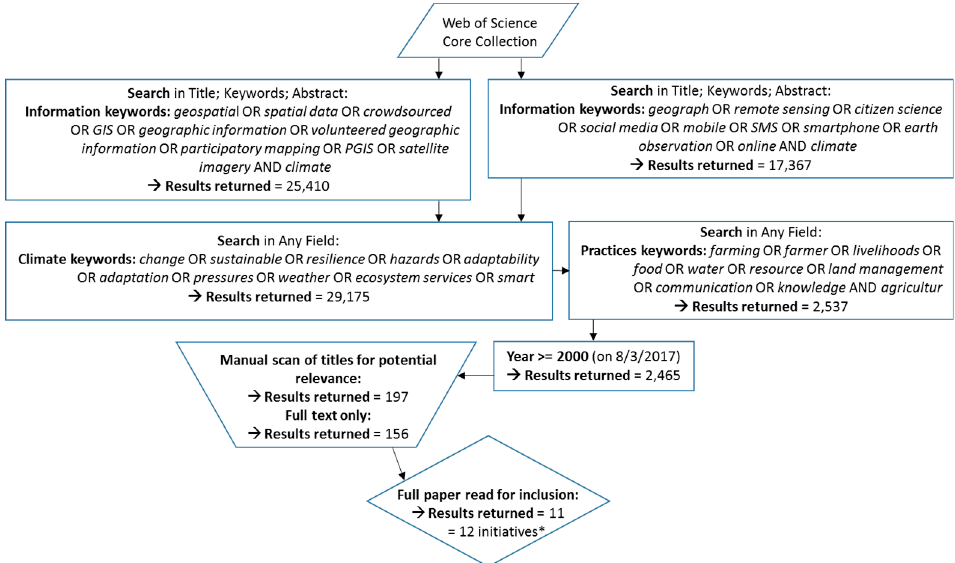
Figure 1. Flow diagram for the academic literature search resulting in 11 relevant papers (12 agricultural geographic information (AGI) initiatives) for analysis (see Table 1 for sources). * One paper described multiple initiatives.